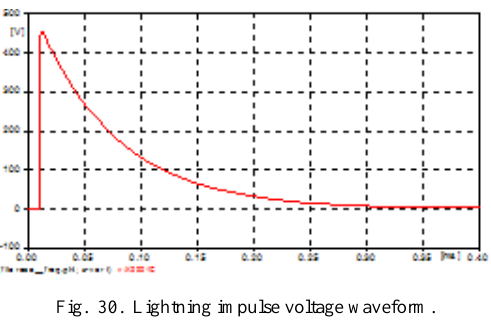
Fig. 29. FFT analysis for secondary side voltages. 5.